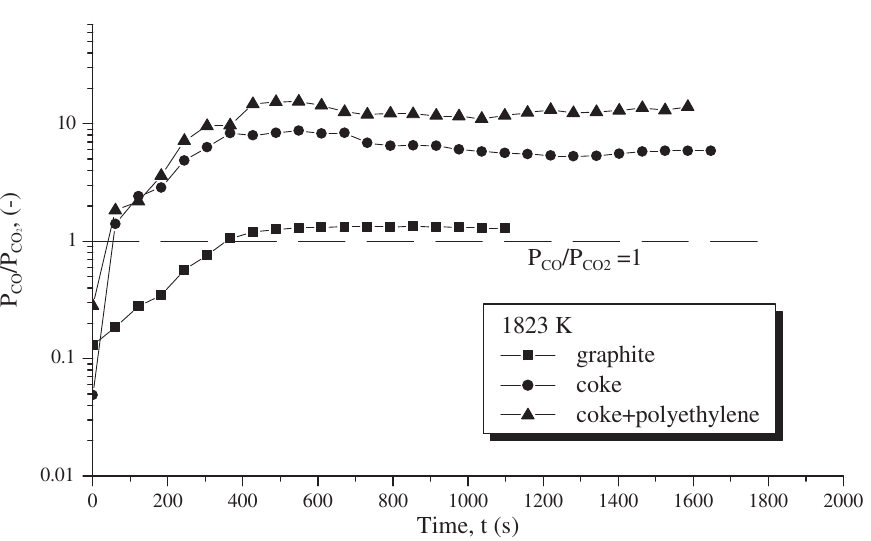
Figure 5: Change of P co /P co2 value with